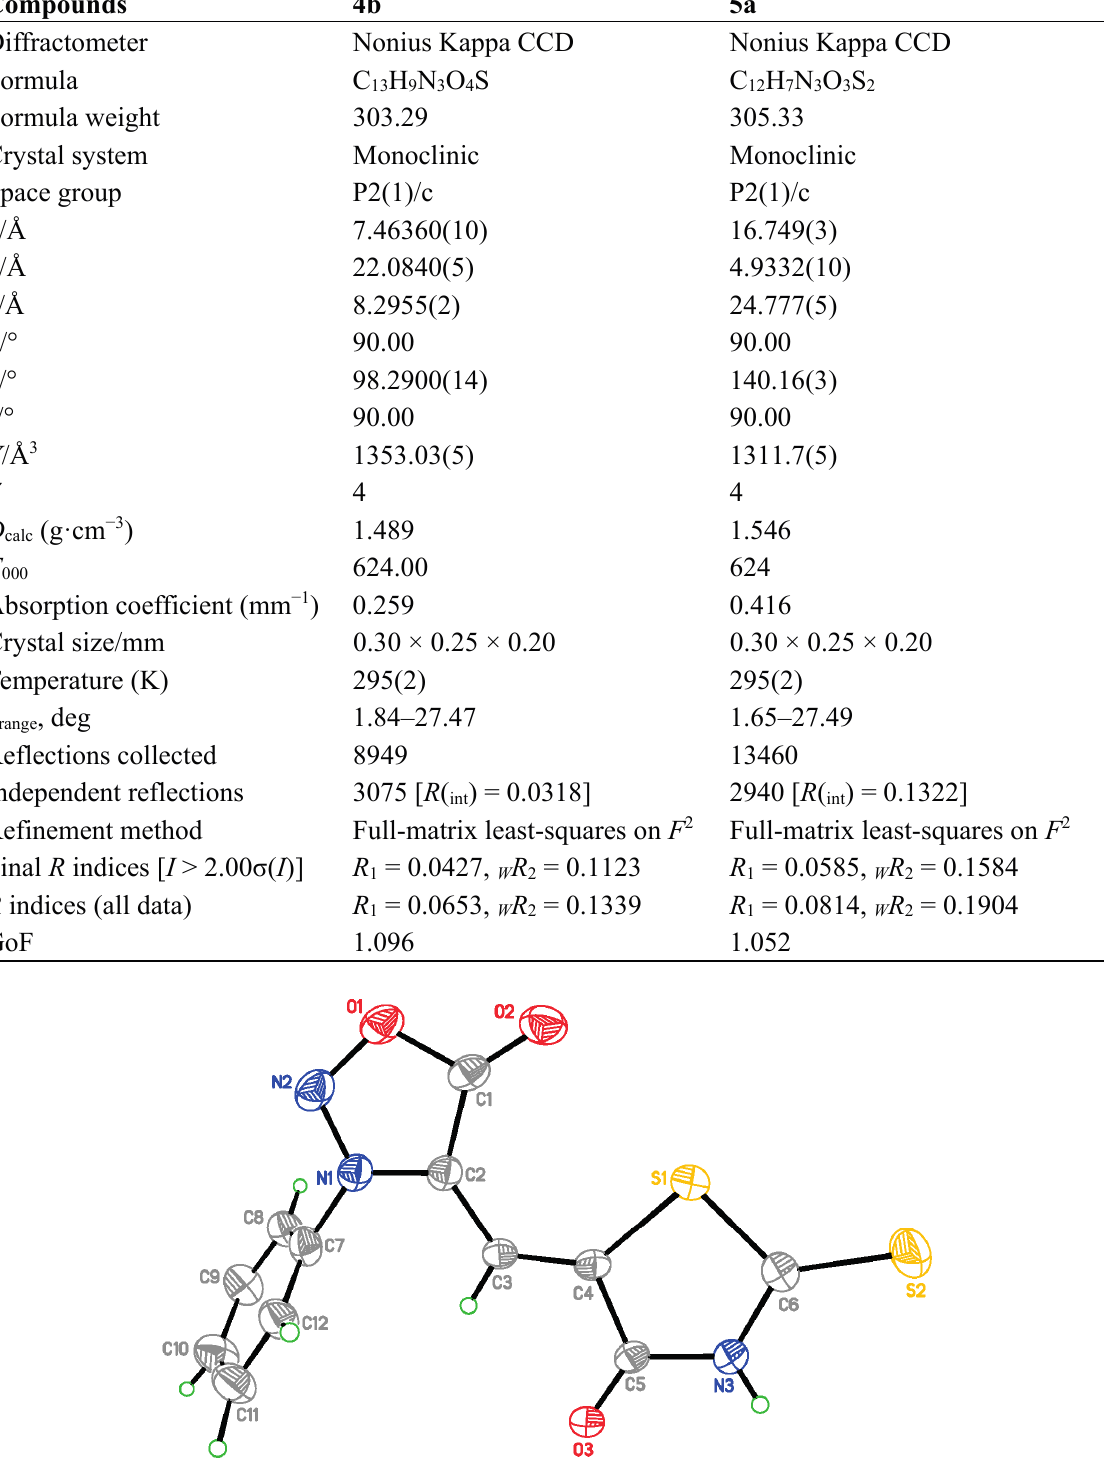
Figure 2. ORTEP drawing of 5-(3-phenylsydnon-4-ylmethylene)-2-thioxothiazolidin-4-one ( 5a